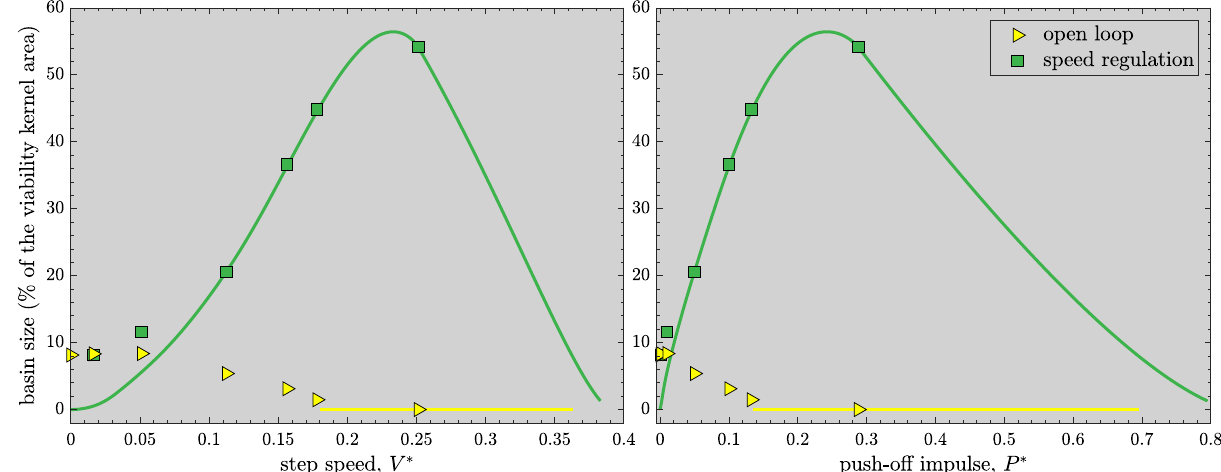
Figure 6. Evolution of the basin sizes (percent of the area of the viability kernel V , Fig. 3) for the open-loop and speed-regulated walkers. Both V ∗ and P ∗ correspond to the steady-state long-period gait. The markers denote sizes of the basins estimated via simulations (Figs. 3, 4, and 5). The solid line for speed regulation denotes analytical approximations of basin sizes when basin boundaries can be predicted (either as level curves and/or coinciding with the boundaries of V ): these predictions match simulations well except when actuation limits significantly affect the basin structure at low speeds or push-offs. The solid line for open loop corresponds to unstable gaits so that their basins are